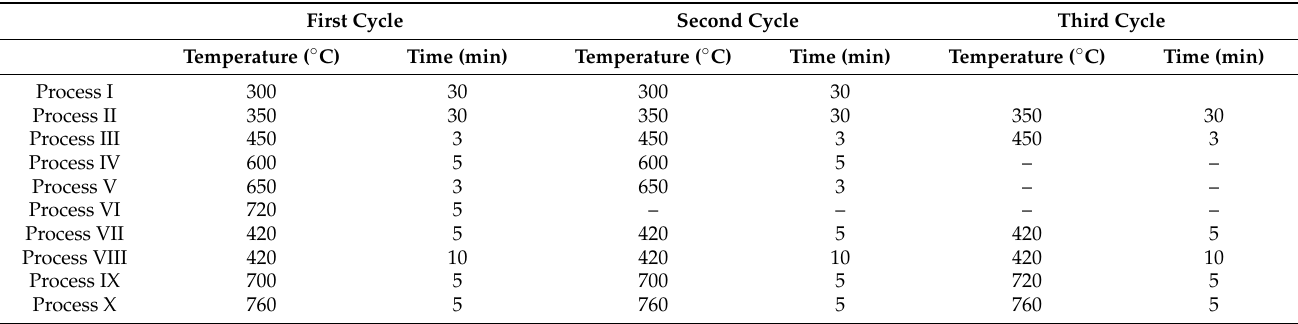
Table 1. Sample annealing parameters of the 10